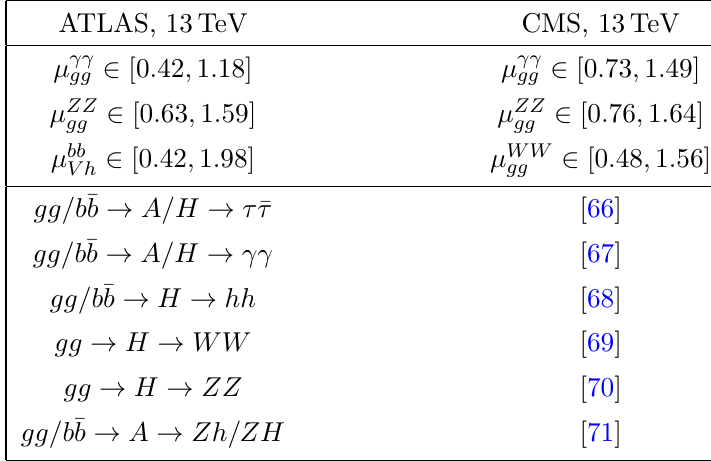
Table 1 . Signal strengths and heavy Higgs searches used in this